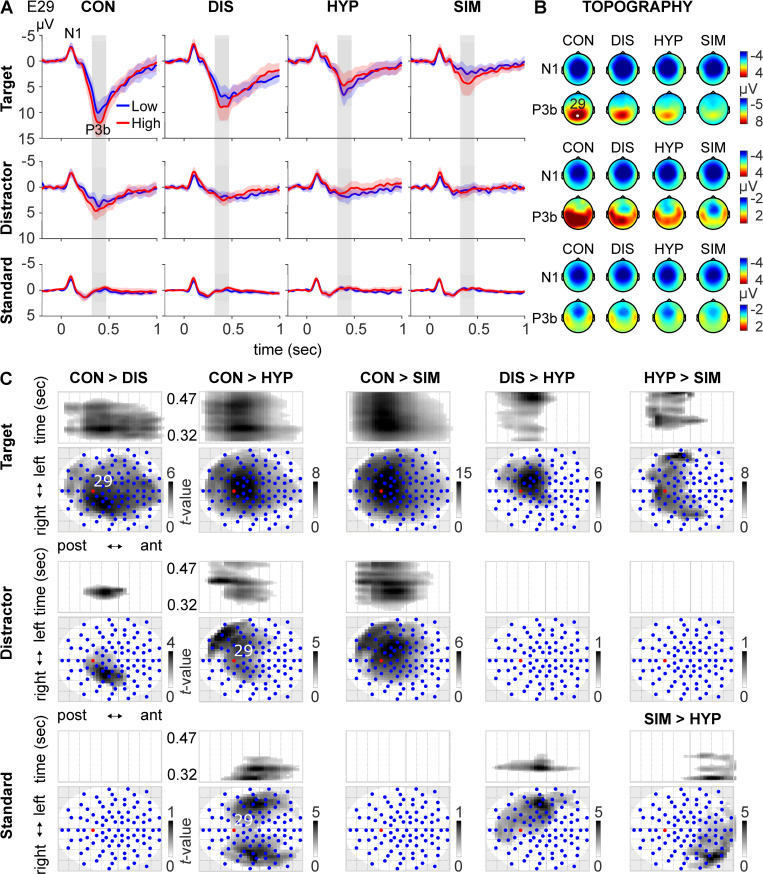
(A) Grandaverage waveforms and 95% C.I. in control (CON), distraction (DIS), hypnosis (HYP), and simulation (SIM) for target, distractor, and standard at the posteriocentral electrode 29 for low (blue, n = 24) and highly susceptible (red, n = 24) participants. The grey rectangle marks the P3b time window (320–470 ms) used for statistical analysis of P3b amplitudes at sensor-level. (B) Topographical maps of scalp voltage at the peak latency of the target N1 (100 ms) and P3b (400 ms) depicted for condition and stimulus-type across all subjects. (C) Focused contrasts within the Topography-by-Time-Cluster-Analysis to disentangle the interaction of condition by stimulus-type. There were no significant amplitude differences for the distractor between DIS and HYP as well as HYP and SIM, and for the Standard between CON and DIS and between CON and SIM. The summary statistic scalp-time images were thresholded at p < .001 (uncorrected) with FWE correction at cluster-level, p < .0017 (two-tailed, Bonferroni-adjusted, n = 15), based on random field theory. The statistical parametric maps (SPMs) are displayed as Maximum Intensity Projection (MIP) of the 3D (scalp x time) summary statistic image. Blue dots mark the electrode sites. post = posterior; ant = anterior.